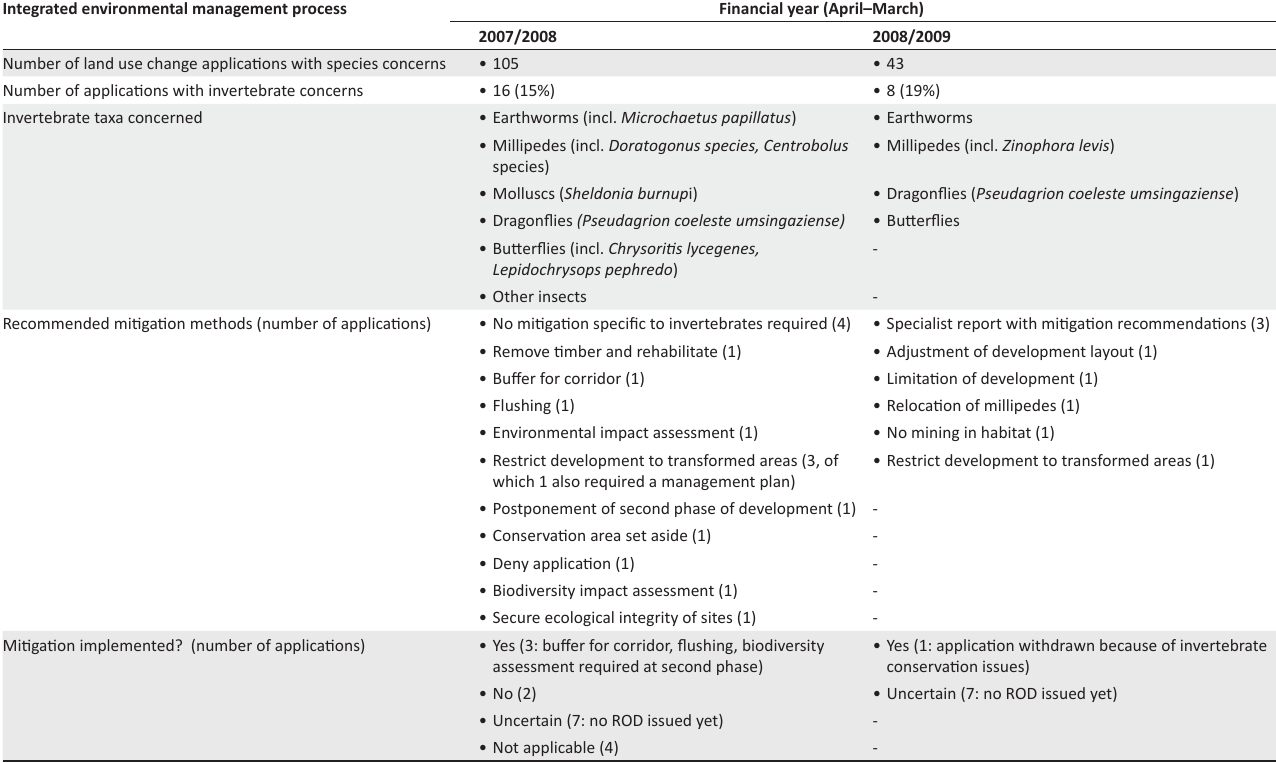
TABLE 2: The number of land use change applications in KwaZulu-Natal with species concerns, and the number of these with invertebrate concerns as ascertained by Ezemvelo KZN Wildlife, the mitigations proposed, and the final decisions by the competent authority. Integrated environmental management